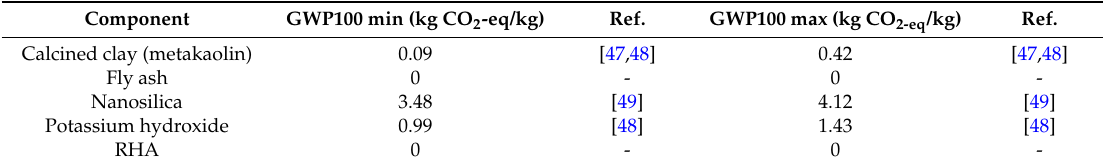
Table 8. Minimum and maximum values of CO 2 eq for each component used in the geopolymeric formulations and the indication of the data sources. GWP, global warming potential. Component GWP100 min (kg CO 2 -eq/kg)